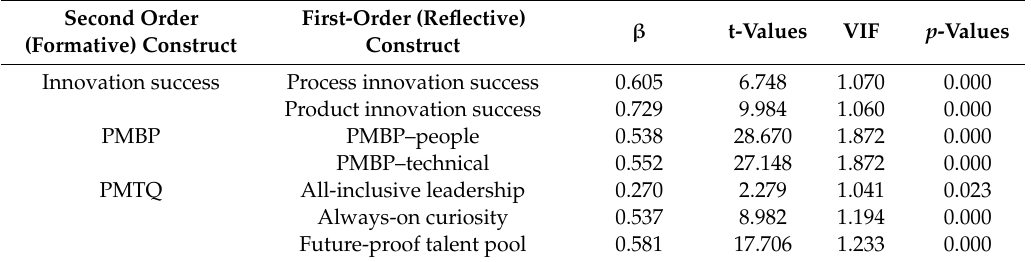
Table 5. Assessments of formative dimensions of project management best practices (PMBP), project management technology quotient (PMTQ), and innovation